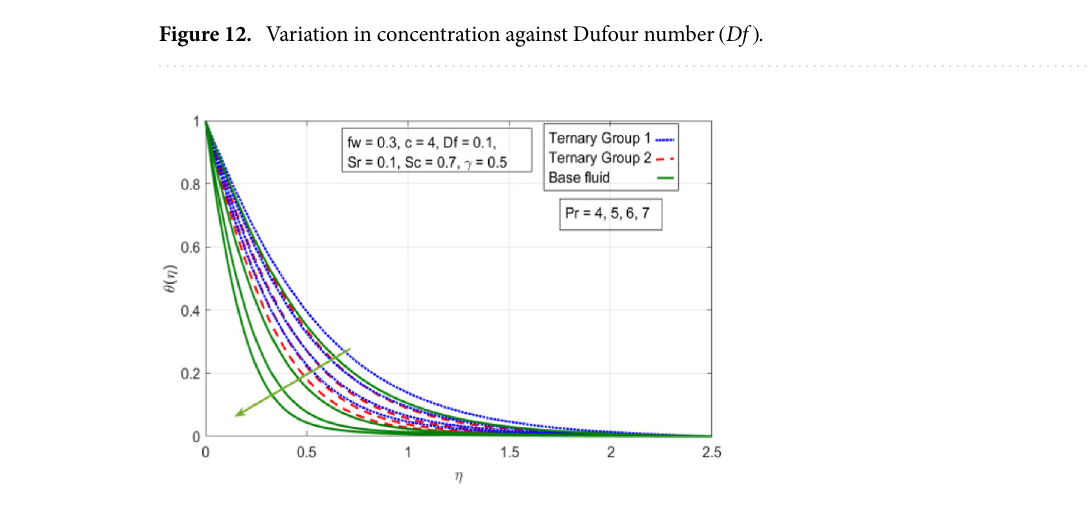
Figure 13. Variation in temperature against Prandtl number (Pr).